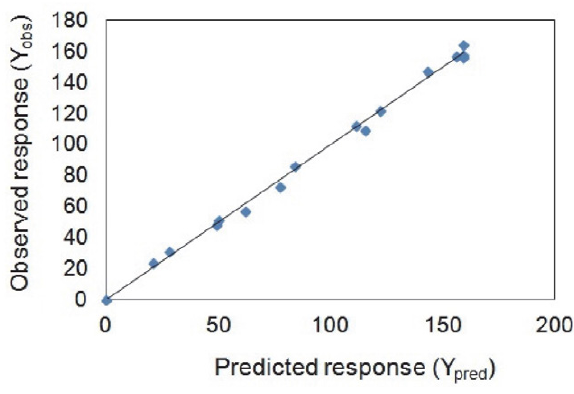
Figure 2. Parity plot showing the goodness-of-fit for RSM model (R 2 = 99.5%).